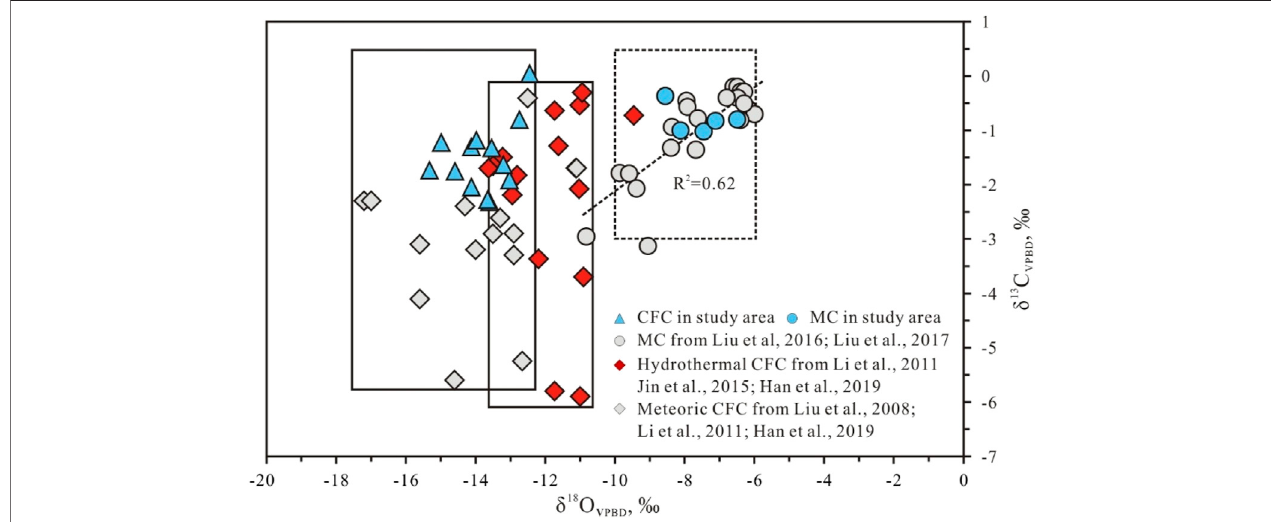
FIGURE 8 | A scatter diagram of δ 18 O and δ 13 C in the Yingshan Formation. The dashed box presents the isotopic value range of Early-Middle Ordovician marine calcite summarized by Veizer et al. (1999). The solid-line areas indicate the isotopic value ranges of various CFCs.